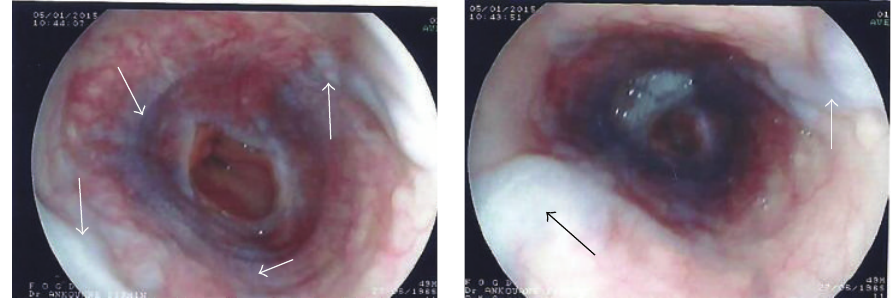
Figure 4: Upper gastrointestinal endoscopy performed after three months on oral anticoagulation. Arrows show medium varices occupying the circumference of the esophageal lumen. Fujinon EG250PE5, Japan. With the permission of the Cathedral Medical Center (CMC) in